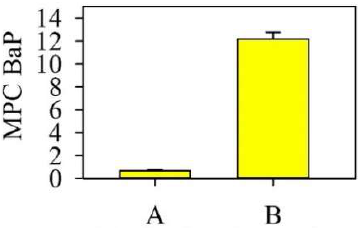
Figure 3. Levels of benzo(a)pyrene (BaP) in the soils of the monitoring sites.